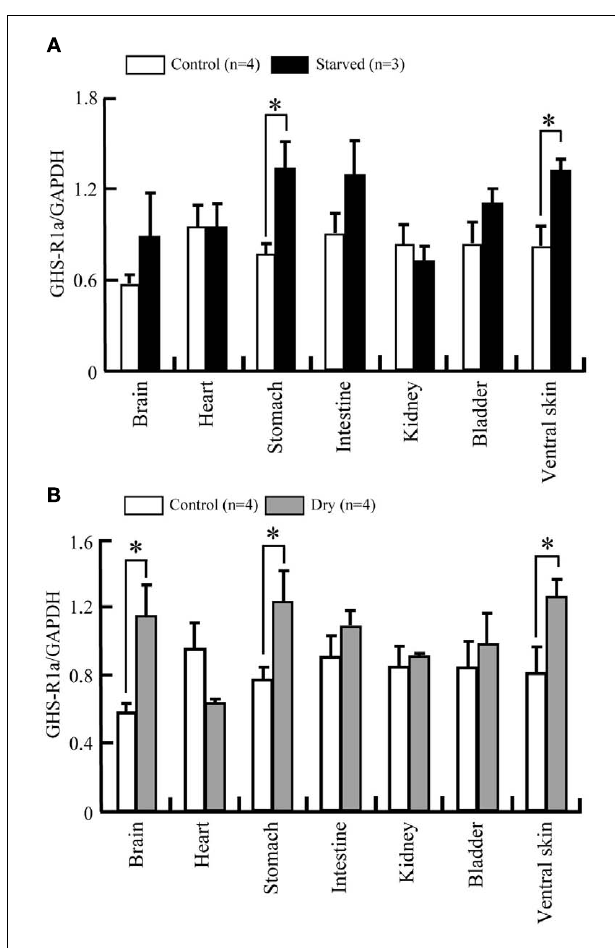
FIGURE 9 | Changes in GHS-R1a mRNA expression in a 10-days starvation and dehydration treatment of Japanese tree frog. mRNA expression levels were estimated semi-quantitatively as a ratio relative to GAPDH mRNA expression in a 10-days starvation experiment (A) and dehydration experiment (B) .Values are the means + SEM. * P < 0.05 compared to the control (unpaired Student’s t -test).